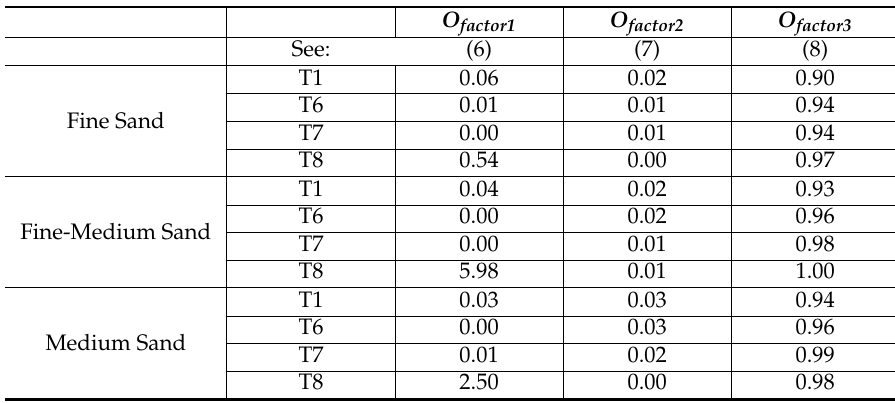
Table 8. Ratios for all O factors